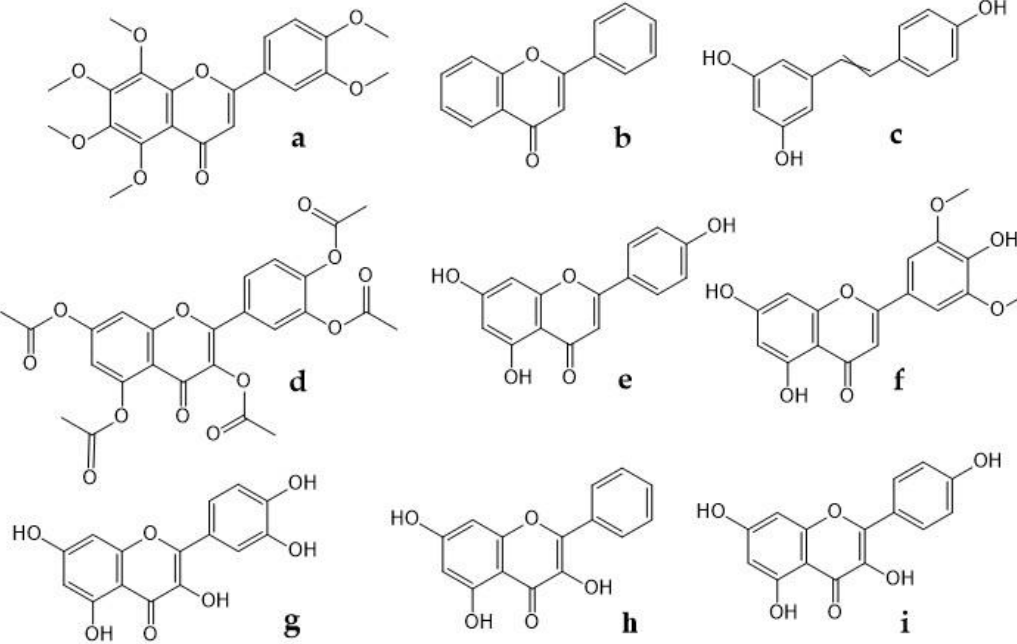
Figure 2. Chemical structure of some flavonoids that modulate COX-2 transcription. ( a ) nobiletin, ( b ) flavone, ( c ) resveratrol, ( d ) quercetin penta-acetate, ( e ) apigenin, ( f ) chrysin, ( g ) quercetin, ( h ) galangin, ( i ) kaempferol.